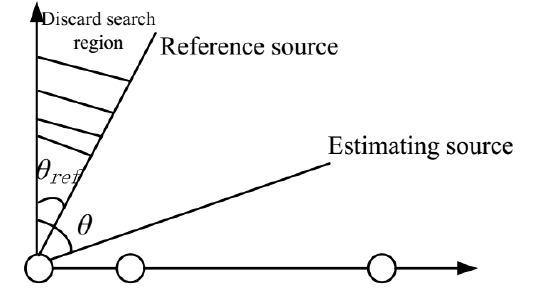
Figure 1. Using a reference source to solve the phase